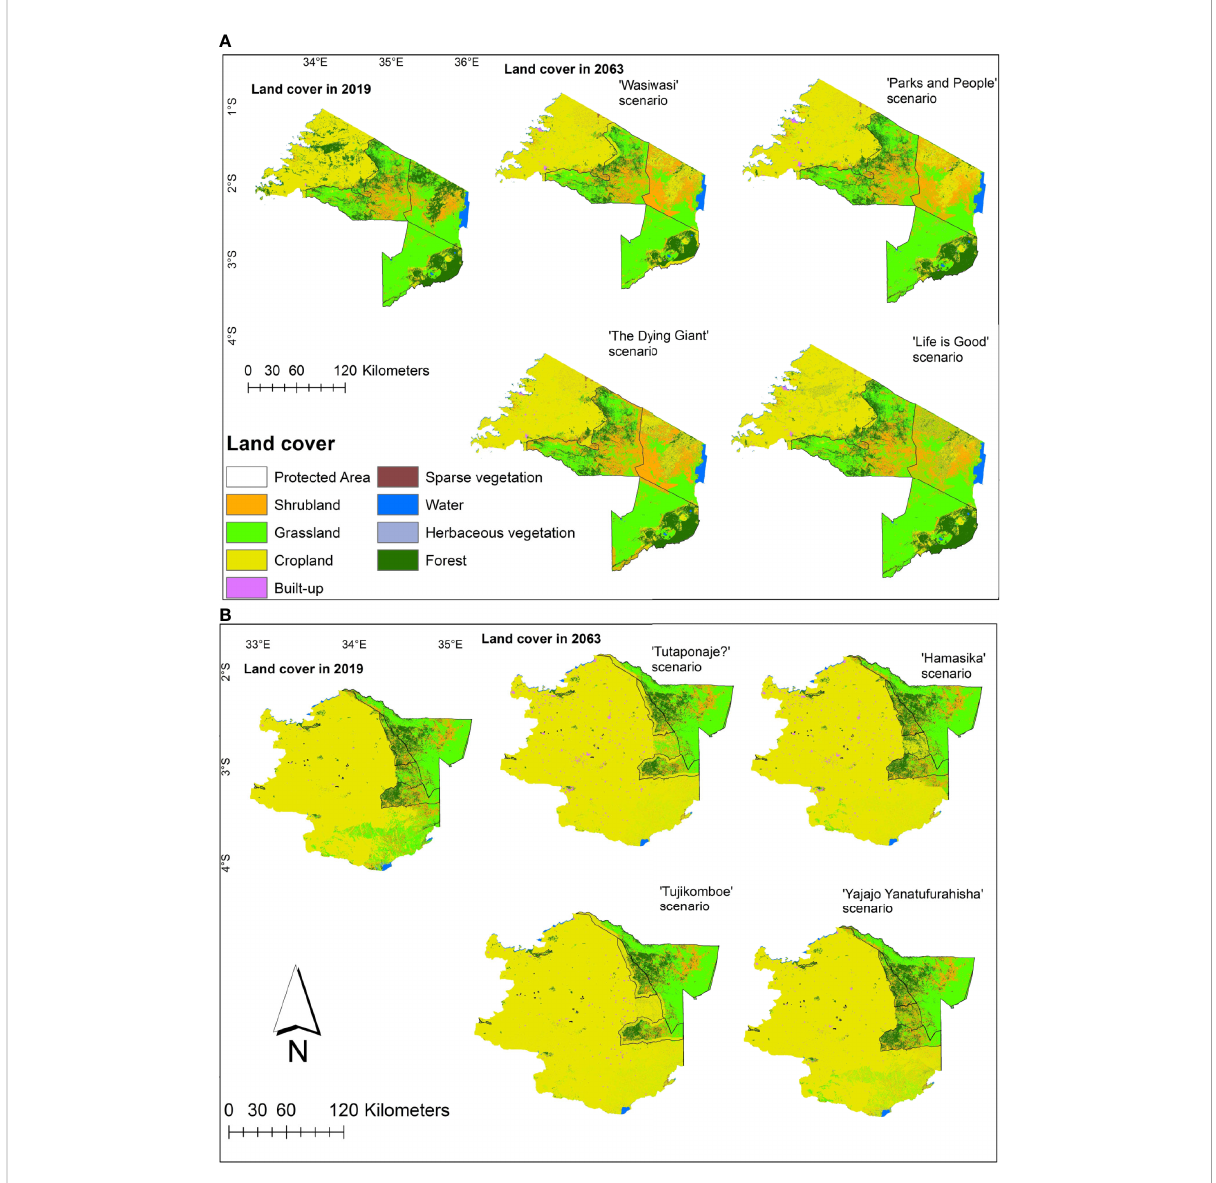
FIGURE 6 (A) Land cover maps for northern and eastern Serengeti from 2019 to 2063 under the Wasiwasi, Parks and People, The Dying Giant, Life is Good scenarios. (B) Land cover maps for southern and western Serengeti from 2019 to 2063 under the Tutaponaje?, Hamasika, Tujikomboe,